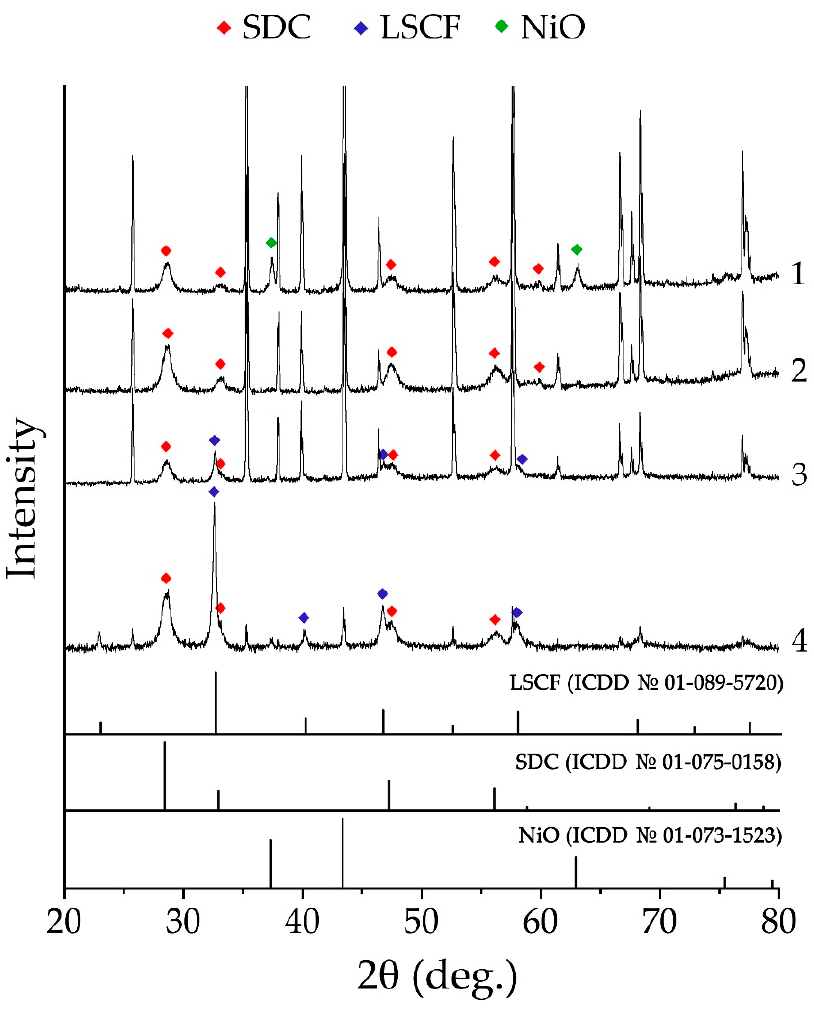
Figure 3. XRD patterns of single- ((NiO-SDC; 1), two- ((NiO-SDC)/SDC; 2), and three-layer ((NiO- SDC)/SDC/(LSCF-SDC); 3 and 4) coatings printed on the surface of Pt/Al 2 O 3 /Pt chip (1–3) and Al 2 O 3 substrate (4). The unmarked reflections refer to the material of the corresponding substrate.